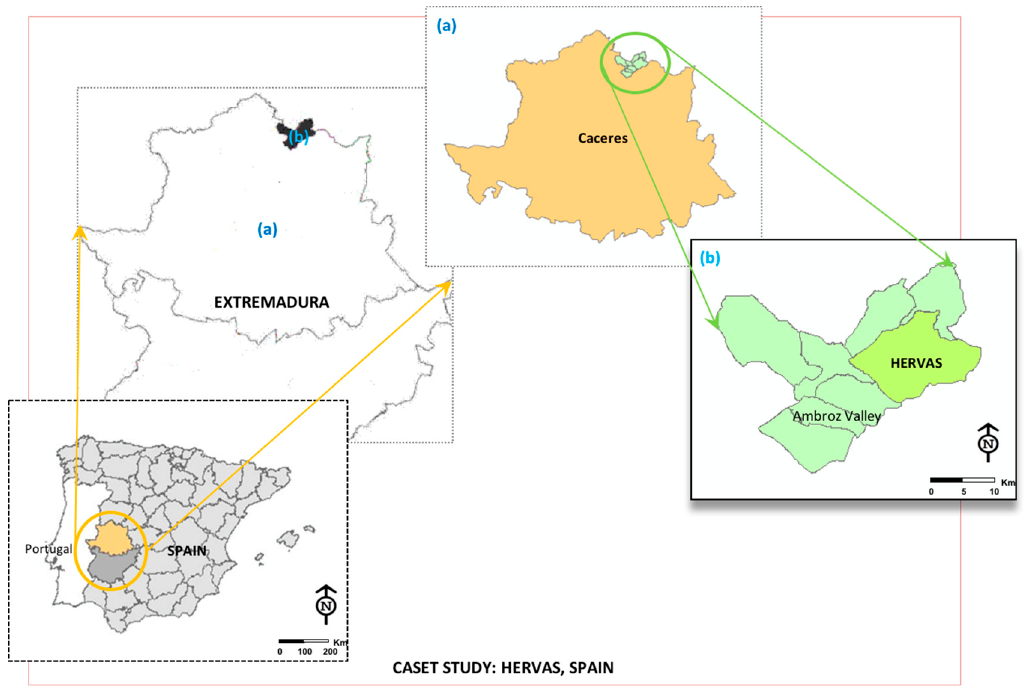
Figure 1. The case study area proposed (Hervas, Spain) for biomass facility site.